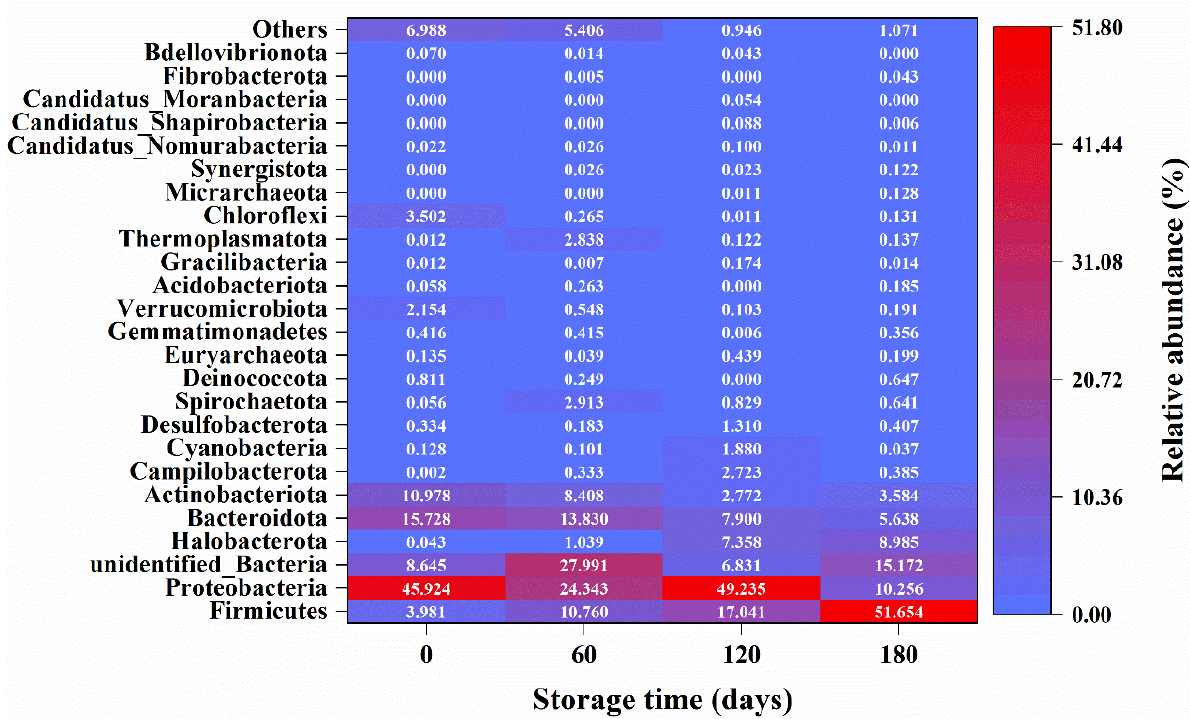
Figure 5. The relative bacterial abundance at phylum level on storage days 0, 60, 120, and 180 in swine wastewater. Data are the means of three replications.